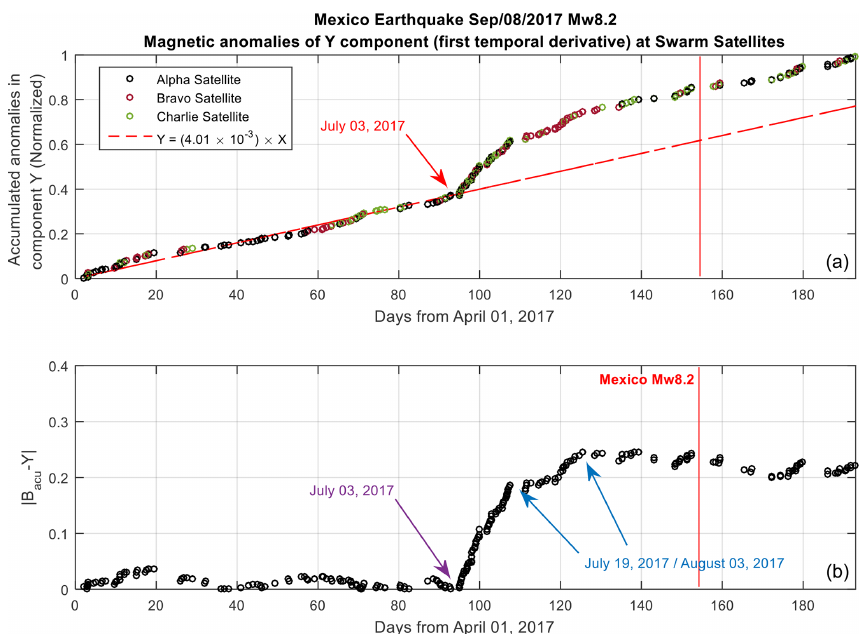
Figure 9. (a) Accumulated diary of magnetic anomalies during 2 years, in component Y from 1 April to 15 October 2017 for the Mexico earthquake of 8 September 2017, M w 8.2. (b) Residual behavior of Mexico earthquake. The data are open source and were taken from the swarm project (https://swarm-diss.eo.esa.int/, last access: 7 June 2021). Methodology was developed by Marchetti and Akhoondzadeh (2018).